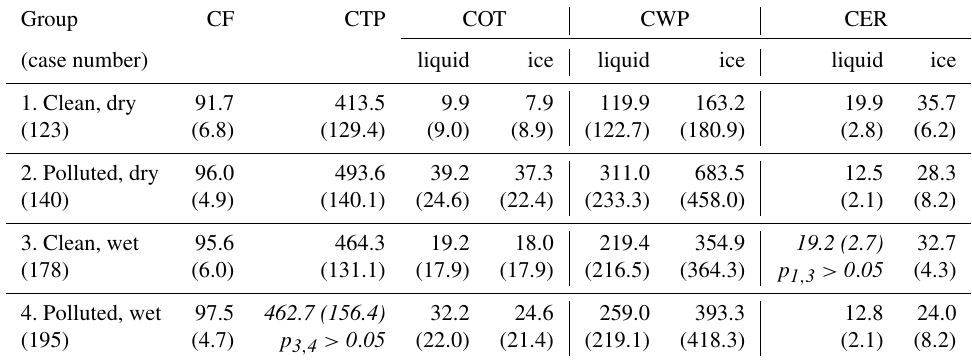
Table 5. The mean values of CF (units: %), CTP (units: hPa), COT (liquid and ice, units: none), CWP (liquid and ice, units: gm − 2 ) and CER (liquid and ice, units: µm) in four groups. Numbers in the brackets stand for the standard deviations on the means. Italic numbers represent that the differences are not significant, in which “ P > 0 . 05” stands for the difference that did not pass the significance test of